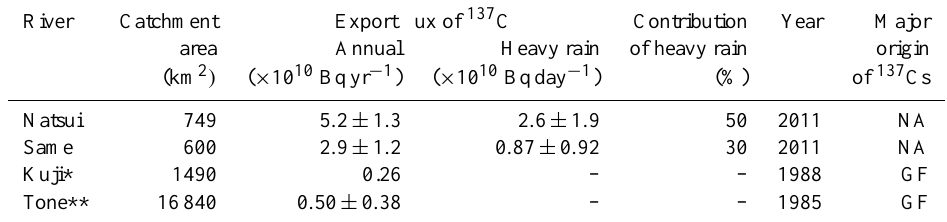
Table 4. Export fluxes of 137 Cs from land to ocean in the Natsui, Same, Kuji and Tone